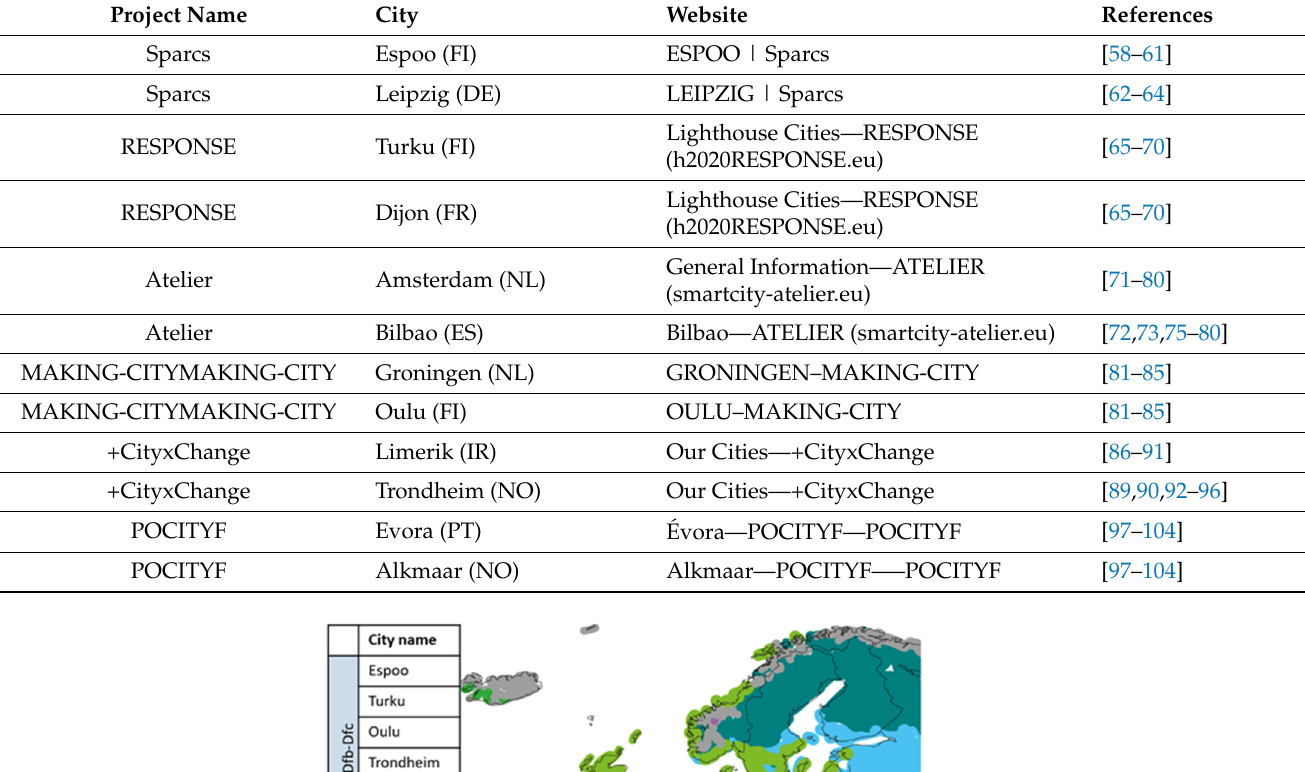
Table 1. Case studies examined.